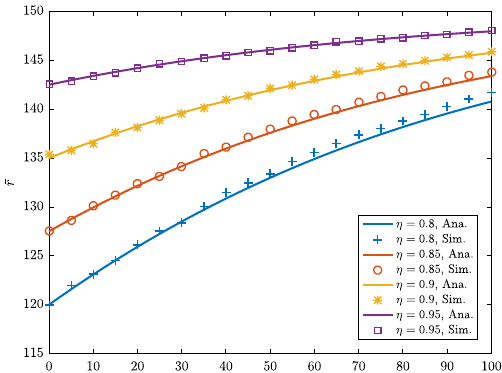
Fig. 5 Simulation and analytical results of the relationships between c and ¯ r ( n , c ) . The figure shows simulation and analytical results of the relationships between c and ¯ r ( n , c ) under n = 150 and η ∈ { 0.8,0.85,0.9,0.95 }